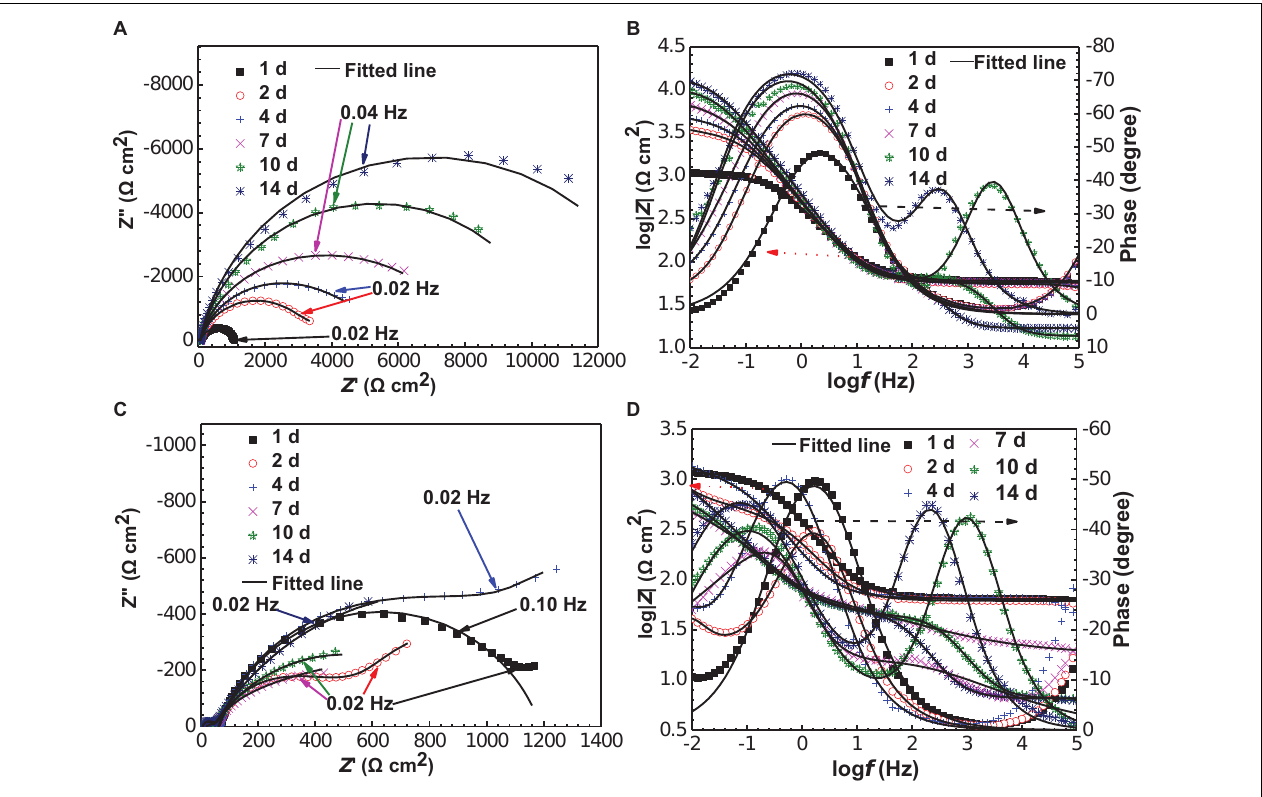
FIGURE 8 | Changes of Nyquist and Bode plots of specimens with time in the absence (A,B) and presence (C,D) of SRB in CO 2 -saturated formation water.